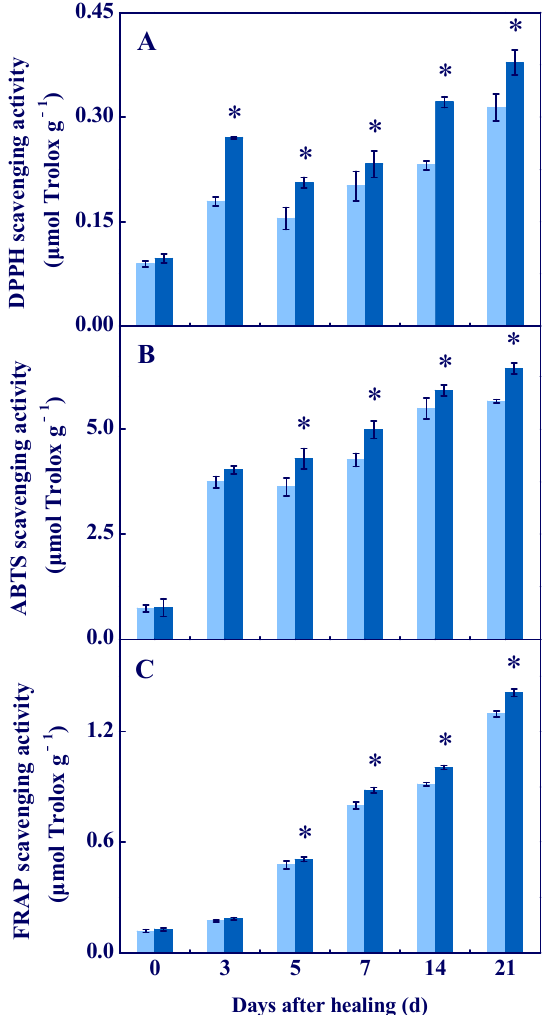
Figure 6. Effect of COS treatment on the scavenging ability of DPPH ( A ), ABTS + ( B ), and FRAP ( C ) at wounds of potato tubers during healing. Bars indicate standard error. Asterisks denote significant differences ( p < 0.05).